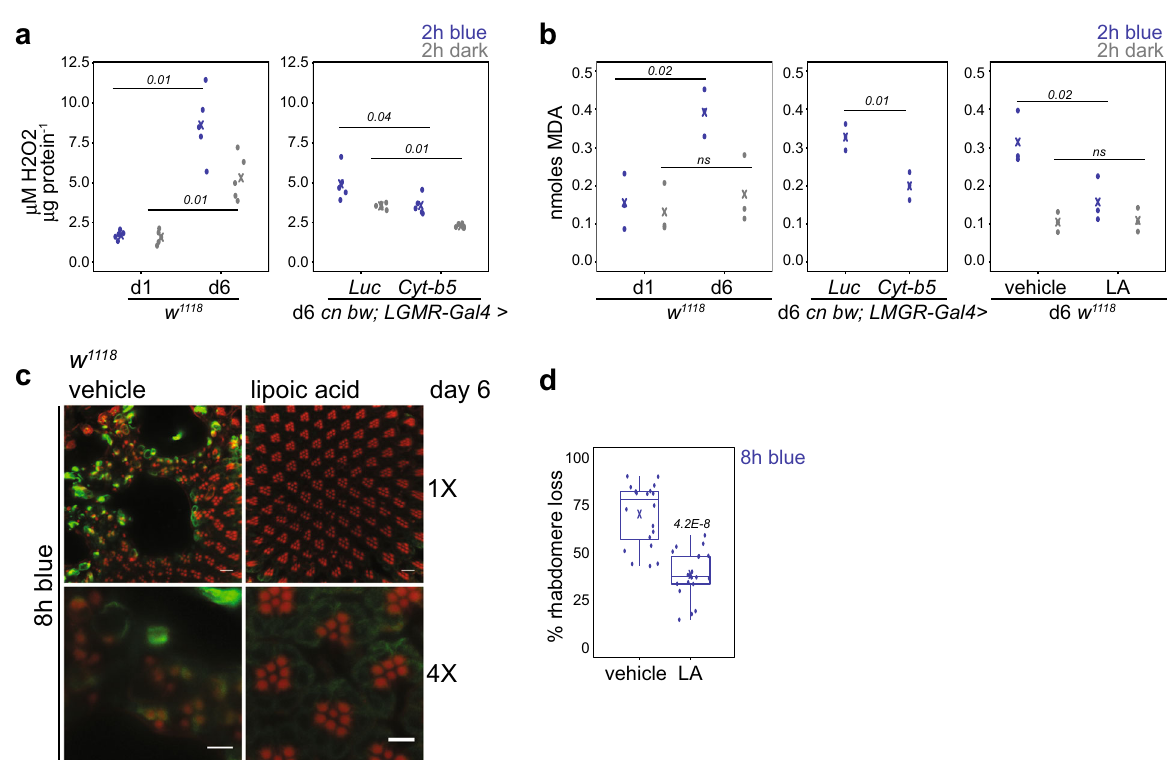
Fig. 6 Reducing lipid peroxidation suppresses blue light-induced retinal degeneration. a H 2 O 2 levels were measured in retinas from fl ies of the indicated ages and genotypes exposed to 2 h blue light or dark control (d1, day 1; d6, day 6). H 2 O 2 concentrations were determined relative to total amount of protein from 10 eyes, and data are plotted as individual points. FDR, pairwise Wilcoxon Rank Sum Test between different genotypes or ages under the same light treatment ( n = 5 light treatments). b Malondialdehyde (MDA) levels were measured in retinas from fl ies of the indicated ages, genotypes, or lipoic acid (LA) treatment, and data are plotted as individual points. p -values, ANOVA followed by Tukey-HSD between different ages, genotypes or treatment under the same light exposure ( n = 3 light treatments ). ns not signi fi cant. c Confocal images of adult retinas from w 1118 fl ies grown on food supplemented with lipoic acid or vehicle (ethanol) for 6 days post-eclosion prior to 8 h blue light exposure. d Box plots showing rhabdomere loss quanti fi ed using the confocal images. p -value, Student ’ s t test ( n = 4 light treatments; 5